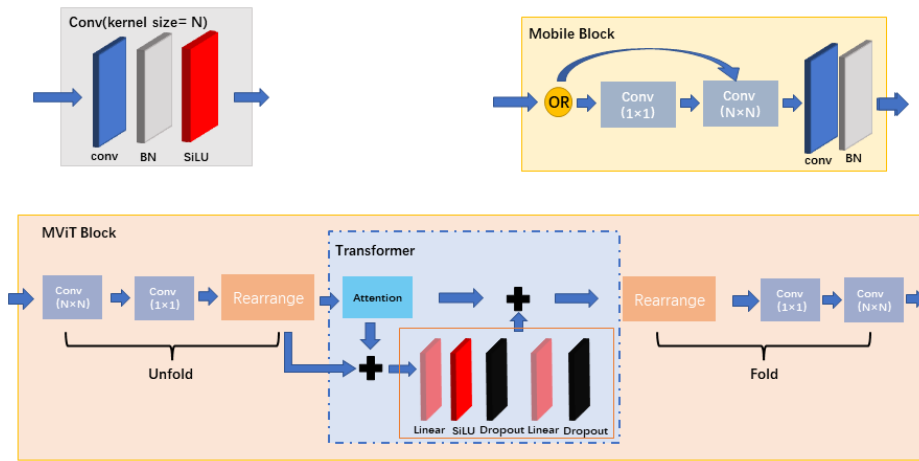
Figure 2. Details of the